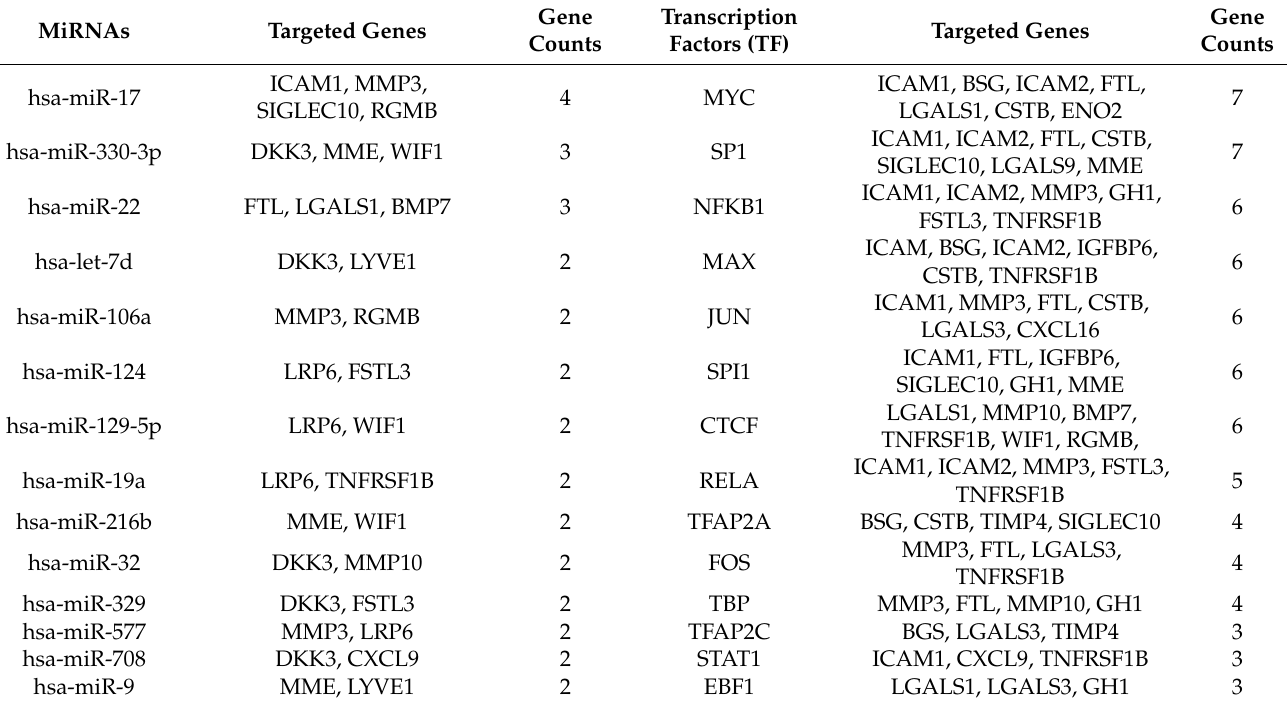
Table 2. TF-miRNA-DEP interacted